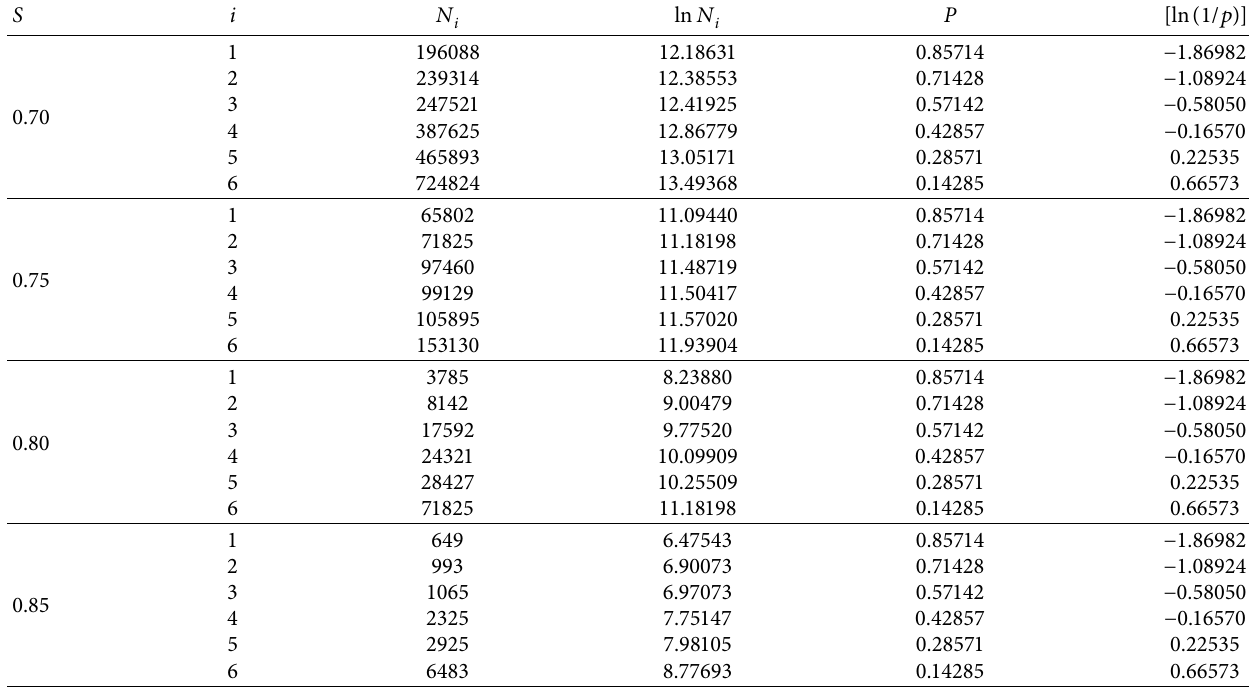
Table 6: Two-parameter Weibull distribution test of the fatigue life of undamaged